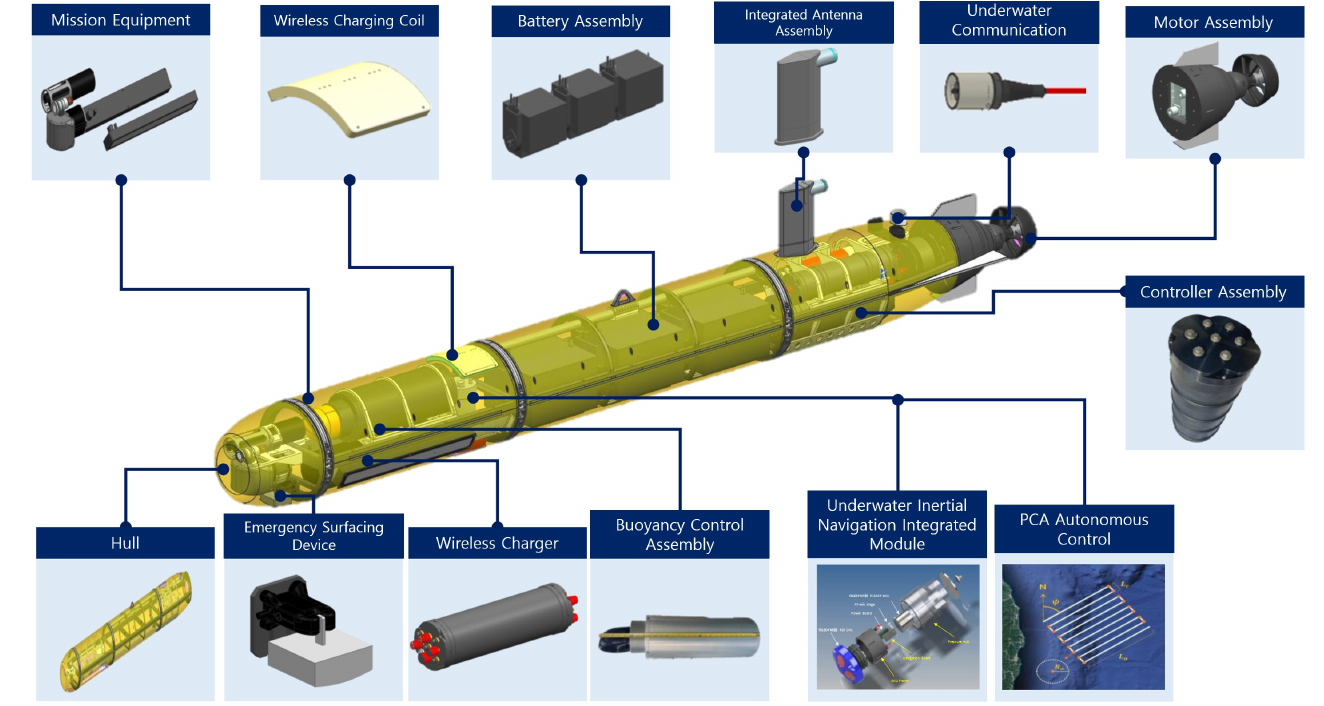
Figure 1. Overview of the autonomous underwater vehicle (AUV) in